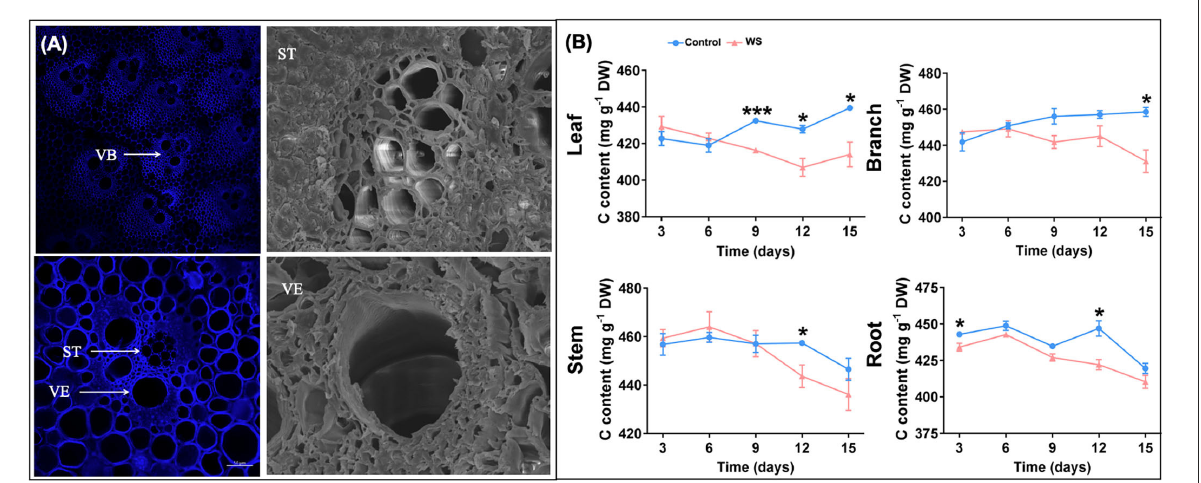
FIGURE5 Phyllostachys heteroclada stem structure images. Vascular bundles are marked as (VB), sieve tubes are marked as (ST), and vessel elements are marked as (VE) (A) ; Effects of waterlogging treatment on the allocation pattern of total C in P. heteroclada (B) . Asterisks indicate the significant differences between treatments (* P < 0.05, *** P < 0.001, t-test).